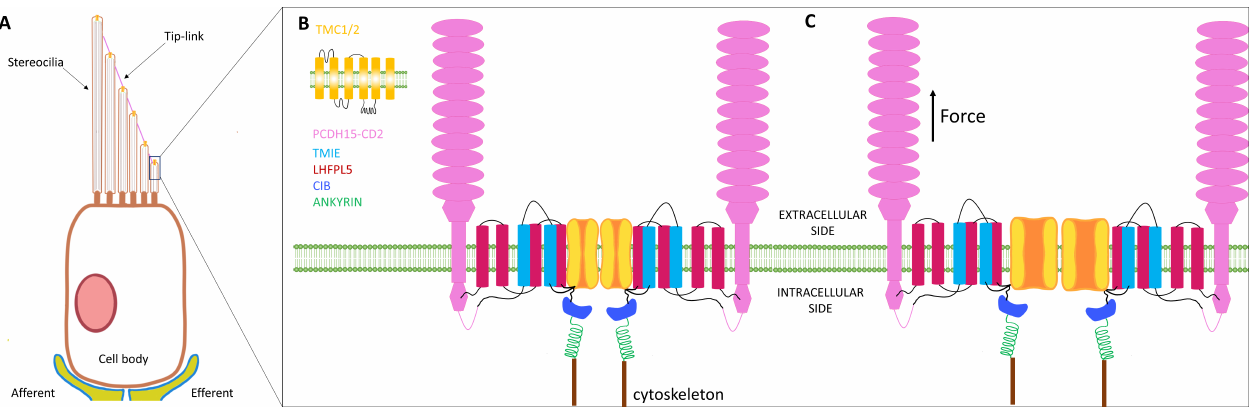
Figure 1. Mechanotransduction in mammalian hair cells. ( A ) Schematic representation of mammalian hair cells. Each hair cell is equipped with a set of interconnected stereocilia with variable length. The bending of the highest stereocilium induces the defection of the other cilia in the bundle and initiates the auditory transduction processes. ( B , C ) Model for mechano-electrical transduction (MeT) (adapted from [4,5]). The conversion of mechanical stimuli into electrical signal happens at the tip of the stereocilia where MeT complexes are localized. MeT complexes have specular stoichiometry and are composed of two Transmembrane Channels (TMCs) that interact with the tip link (PCDH15-CD2, in pink) through the TMIE and the LHFPL5 proteins [5–11]. In addition, the channel directly interacts with the Calcium Binding Protein-2 (CIB-2) [9,12]. A recent study on the Caenorhabditis elegans ( C. elegans ) model organism showed that the connection of the complex with the cytoskeleton is realized through the binding of the CIB protein with ankyrin protein UNC-44 [9]. However, in mammals, this aspect is still poorly explored, and the target of CIB-2 proteins is